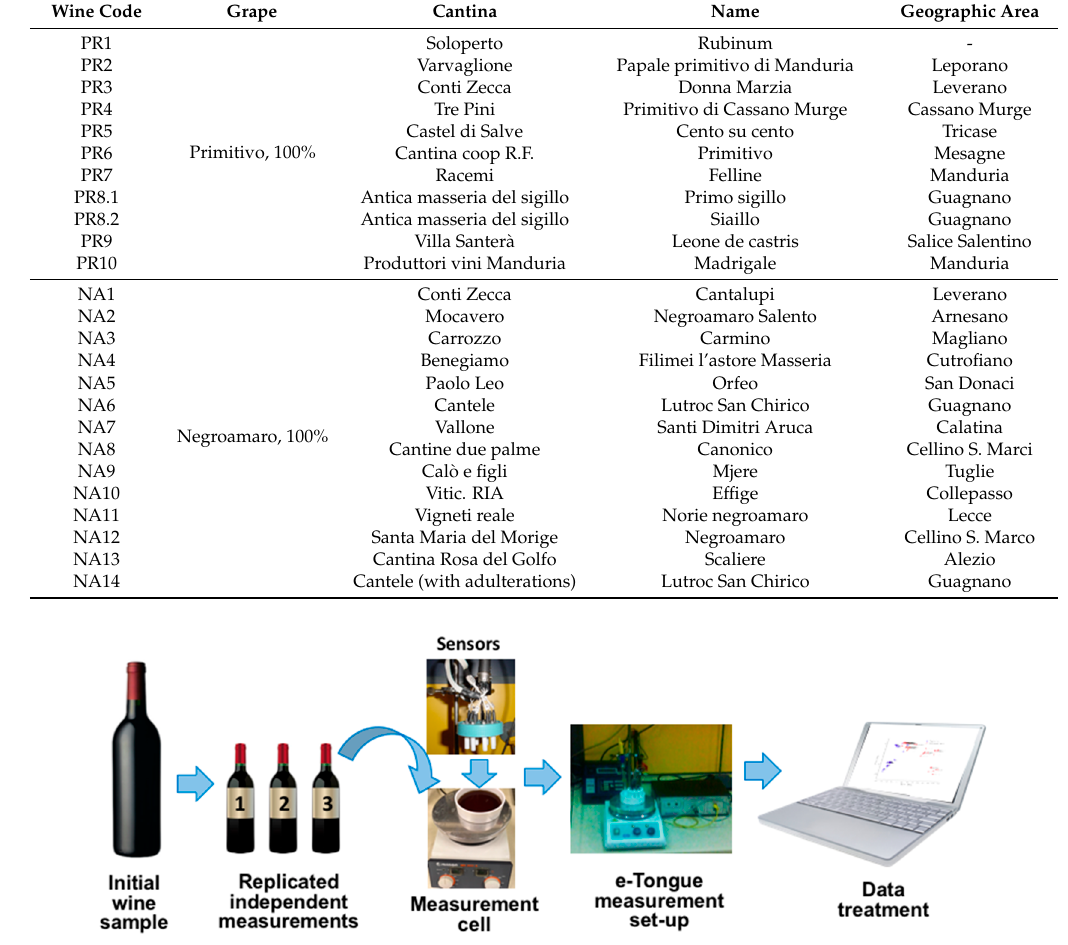
Table 3. The amounts of wine defect compounds in artificial wine calibration solutions and in Negroamaro wine (NA14). Defect Compound